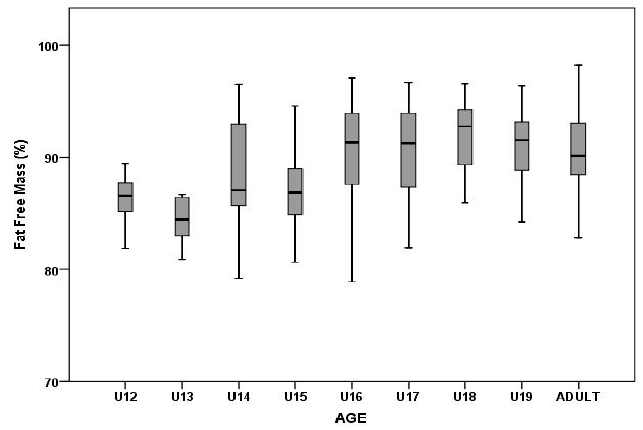
Figure 3. Differences in fat mass among different age groups.